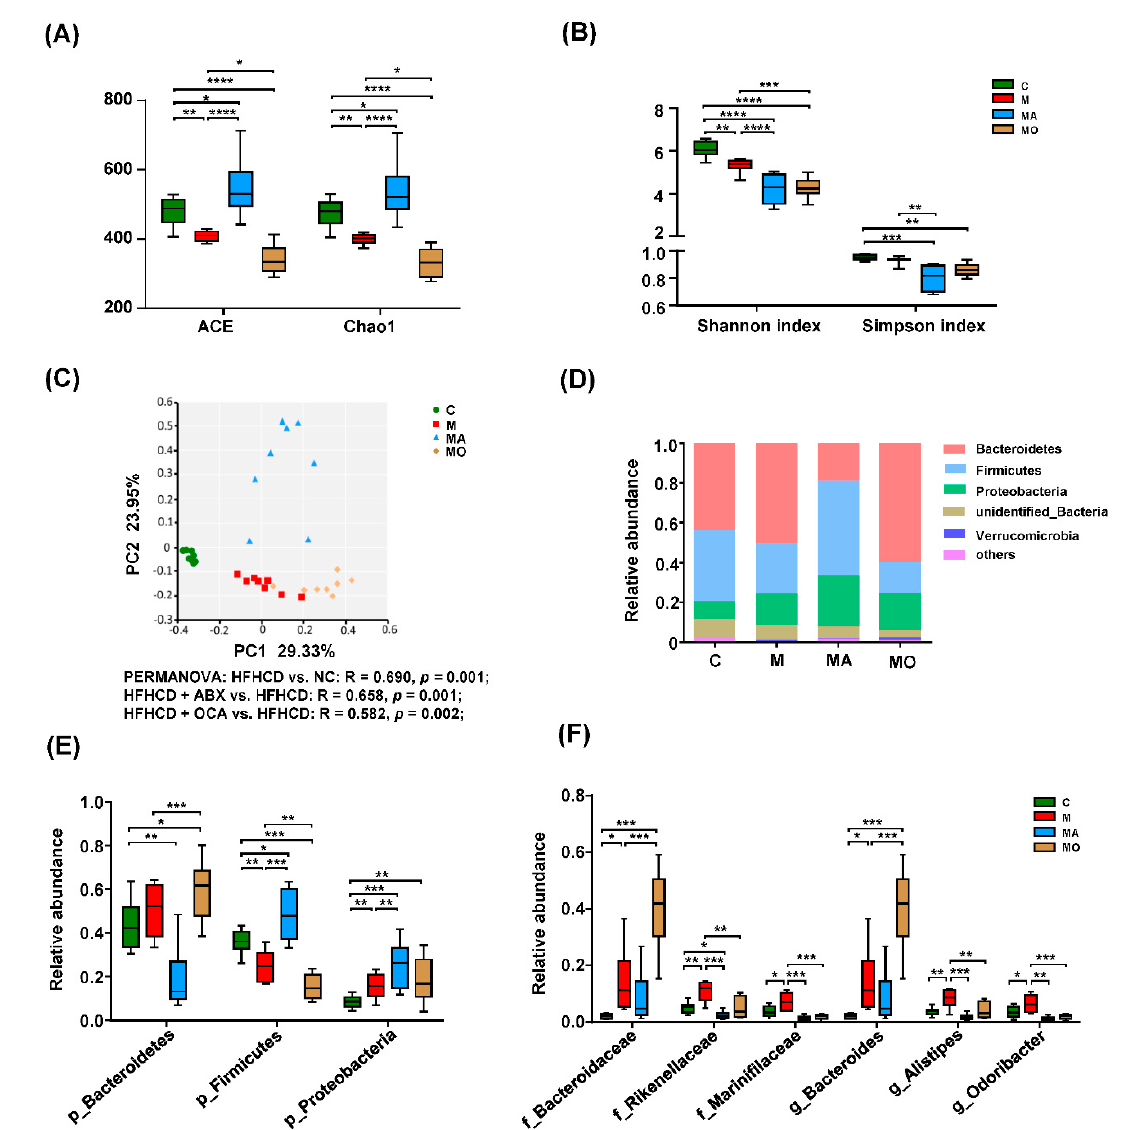
Figure 5. OCA supplementation modified the microbial community in HFHS diet mice. ( A , B ) The α -diversity indexes reflecting microbial richness and diversity were calculated. ( C ) The β -diversity indicated the differential microbial community among normal chow mice and HFHS diet mice with or without OCA or ABX treatment. The predominant phyla ( D ) and OCA-affected microbes at ( E ) phylum and ( F ) family and genus levels. Note: data are given as mean ± SEM or medians with range. n : ( A – F ) 8 per group. * p < 0.05; ** p < 0.01; *** p < 0.001; **** p < 0.001. Groups: C, mice with normal chow; M, mice with HFHS diet; MA, ABX-treated HFHS diet mice; MO, OCA-treated HFHS diet mice. Abbreviations: HFHS, high-fat high-sugar; PCoA, principal coordinates analysis; ABX, antibiotics; OCA, obeticholic acid; p, phylum; f, family; g, genus.